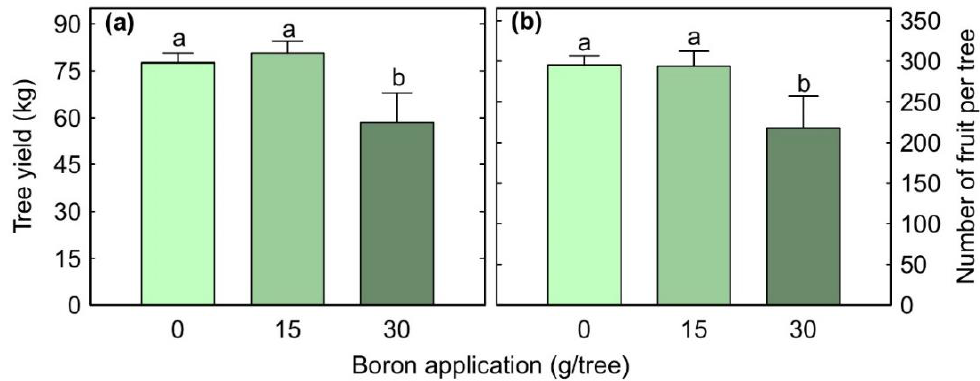
Figure 4. ( a ) Yield and ( b ) number of fruit harvested from Hass avocado trees treated with 0, 15 or 30 g boron (B) per tree prior to anthesis. Means (+SE) with different letters are significantly different (generalised linear models, p < 0.05, n = 10 trees).